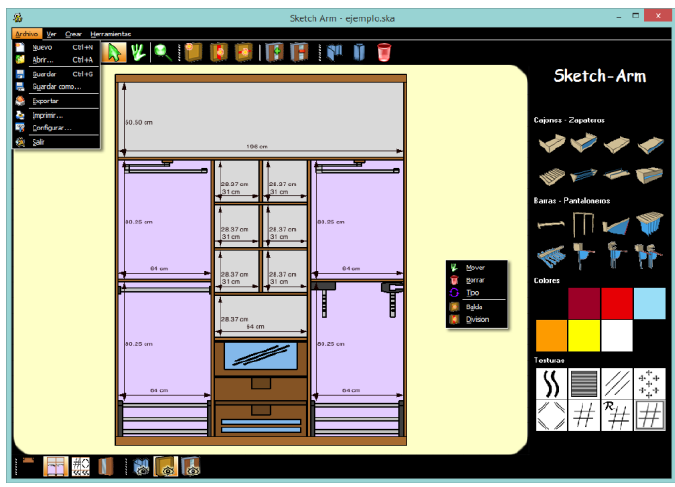
Figure 12. Look and feel of Sketch Arm ’ s GUI for desktop systems .